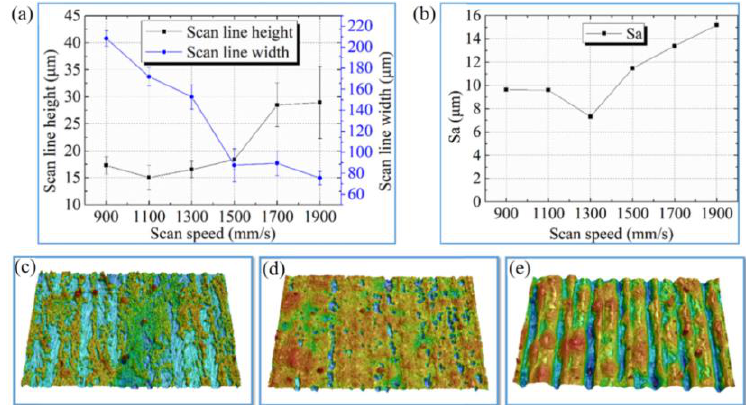
Figure 5. The variation in ( a ) scan line dimension, ( b ) the roughness of scan layers, and ( c ) the morphology of scan layers of SLM-processed 1 wt.% carbon nanotubes (CNT)/AlSi10Mg composite powder as a function of the scanning speed. The micrographs provided in ( c ), ( d ), and ( e ) refer to the parts subjected to the scanning speed of 900, 1300, and 1700, respectively [70].